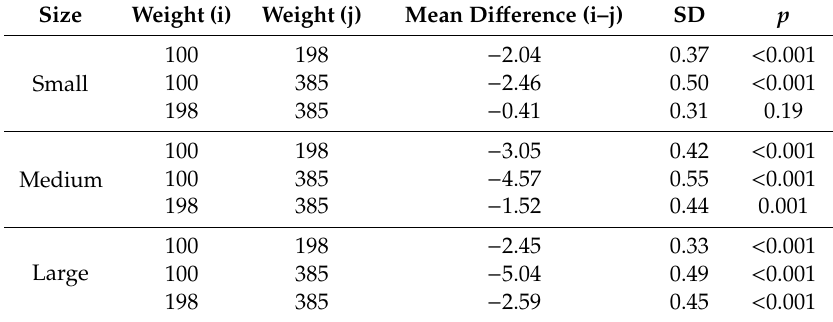
Table 9. Satisfaction comparison of the three cookie box